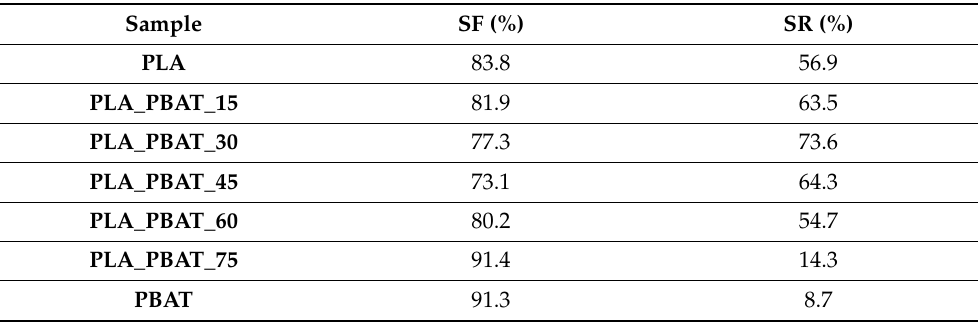
Table 6. Strain fixity and strain recovery parameters of neat PLA, neat PBAT and PLA/PBAT